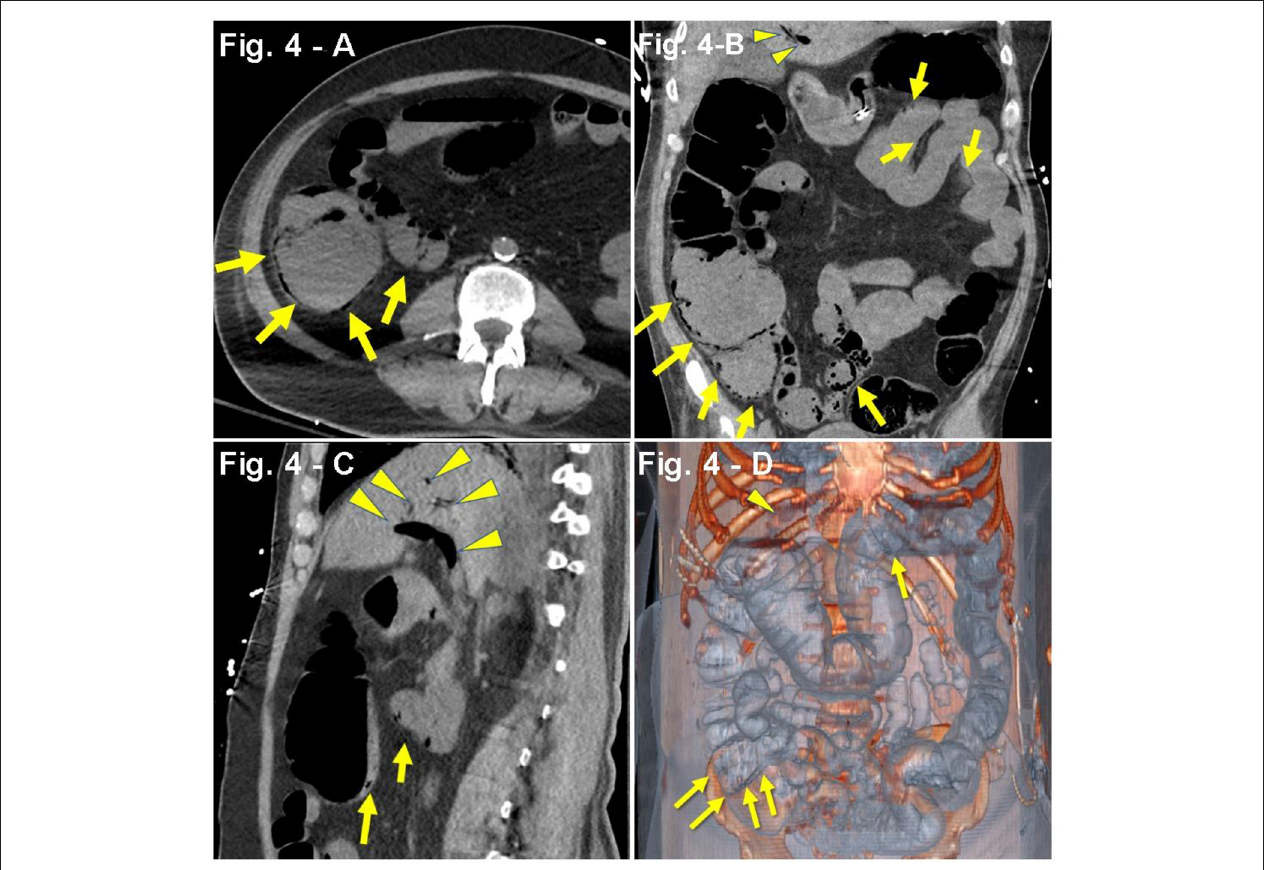
FIGURE 4 | (A–D) Case presentation of a 64-year-old male patient, with altered mental status, acute kidney injury, DM2, stroke, bacterial pneumonia with COVID-19, single-dose TCZ, hypotensive, oliguric, non-contrast abdominal CT only, (A) axial, (B) coronal, (C) sagittal, and (D) 3D reconstruction with pneumatosis of distal transverse colon, cecum, terminal ileum, and mesenteric venous gas adjacent to the terminal ileum (yellow arrows) concerning for bowel ischemia. There are foci of air in mesenteric vessels in the right lower quadrant, with portal venous gas (yellow